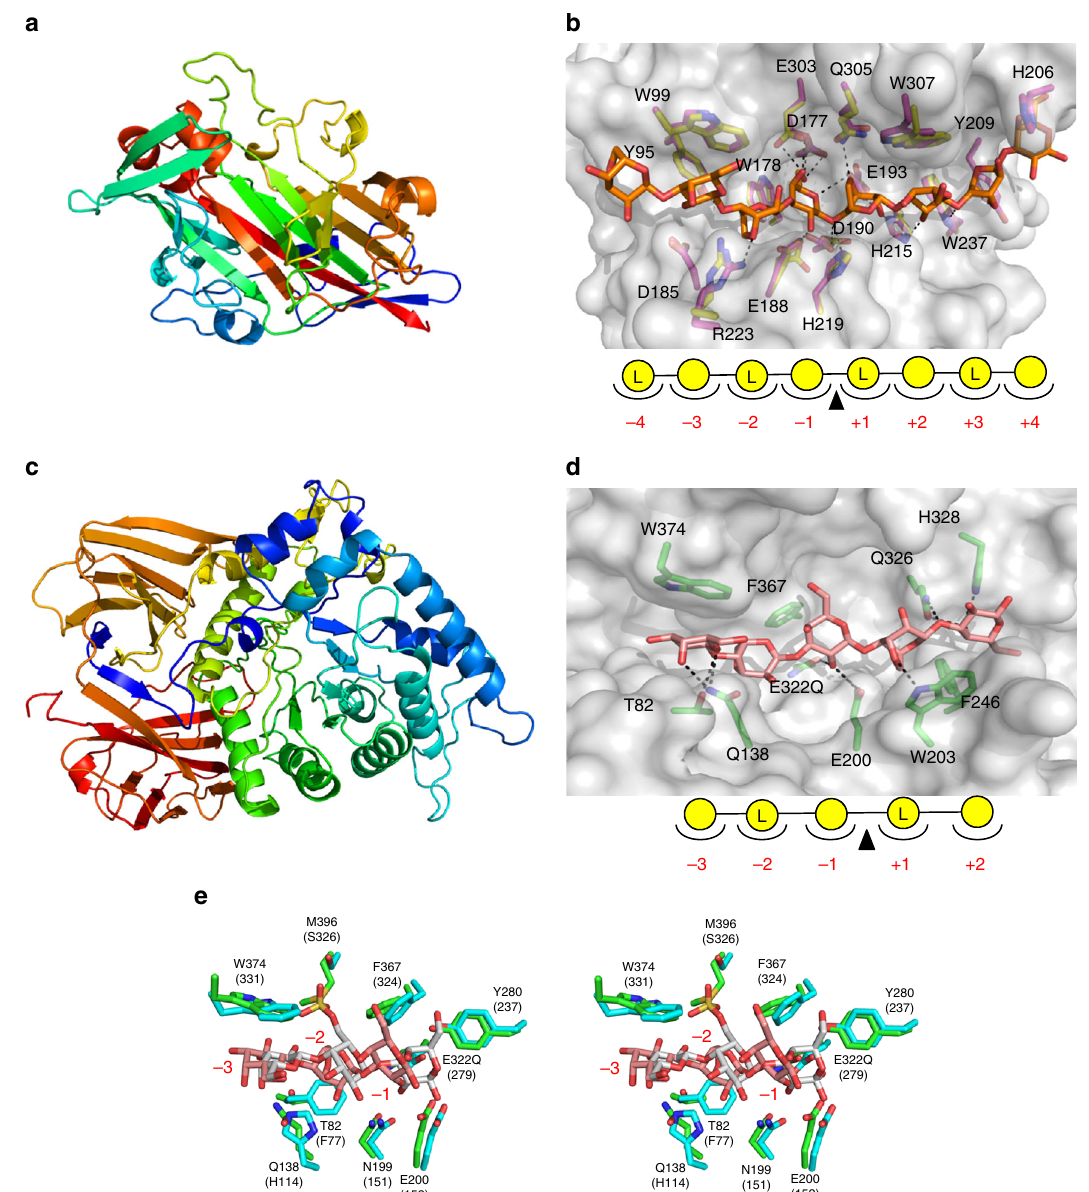
Fig. 3 Molecular basis of endo- acting agarases from Bu NP1. a Structure of GH16B shown in cartoon format color ramped from N terminus (blue) to C terminus (red). b Surface representation (gray) of the GH16B catalytic groove. Key GH16B residues, shown as numbered purple sticks and labeled, are overlapped with structurally conserved residues from Z. galactanivorans AgaB (yellow) in complex with N8 (orange) (pdb entry: 4ATF 17 ). The subsites are indicated below and hydrogen bonds are represented by dashed lines. c Structure of GH86 shown in cartoon format color ramped from N terminus (blue) to C terminus (red). d Surface representation (gray) of the GH86 active site in complex with N8 (modeled residues for A5 shown in pink). Key residues are numbered and shown in green. The subsites are indicated below and hydrogen bonds are represented by dashed lines. e Wall-eyed stereo view of the − 1, − 2, and − 3 subsites using the structural alignment of GH86 (green) in complex with N8 (pink) with Bp GH86A (cyan) in complex with a porphyran/ agarose hexasaccharide (gray) (pdb entry 4AW7 31 ). Key GH86 residues are numbered, with corresponding Bp GH86 residues in